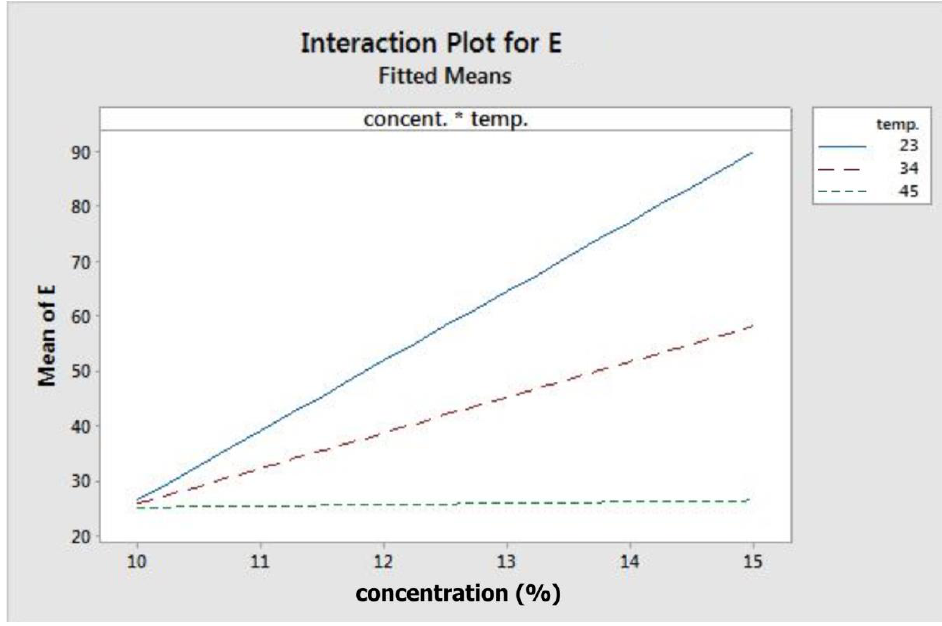
Figure 4. Interaction plot for modulus elasticity.